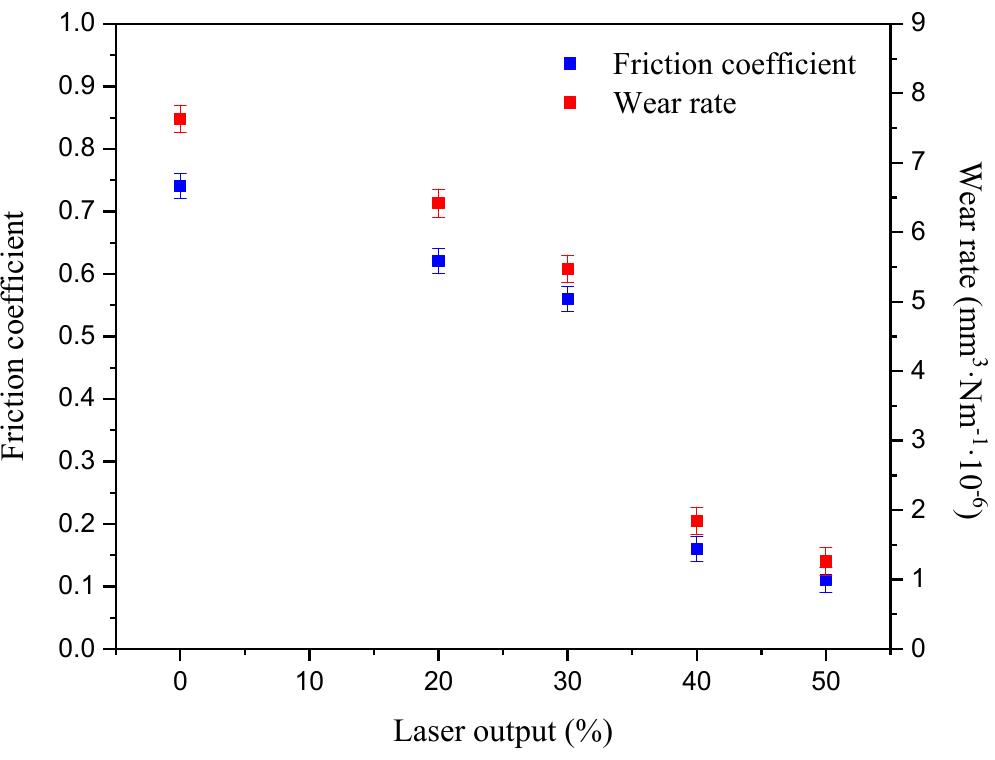
Figure 6. Friction coefficient and wear rate of as-deposited TiZrN and carbon-doped TiZrN.